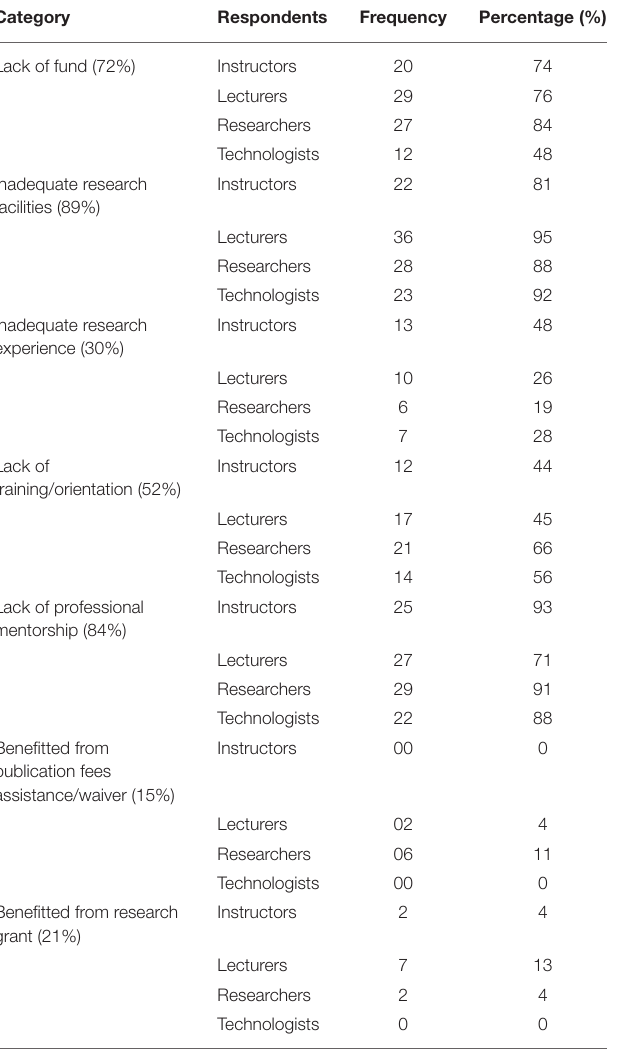
TABLE 2 | Barriers toward conducting research and publishing of articles that are specific among the different cadres of respondents. Category Respondents Lack of fund (72%)